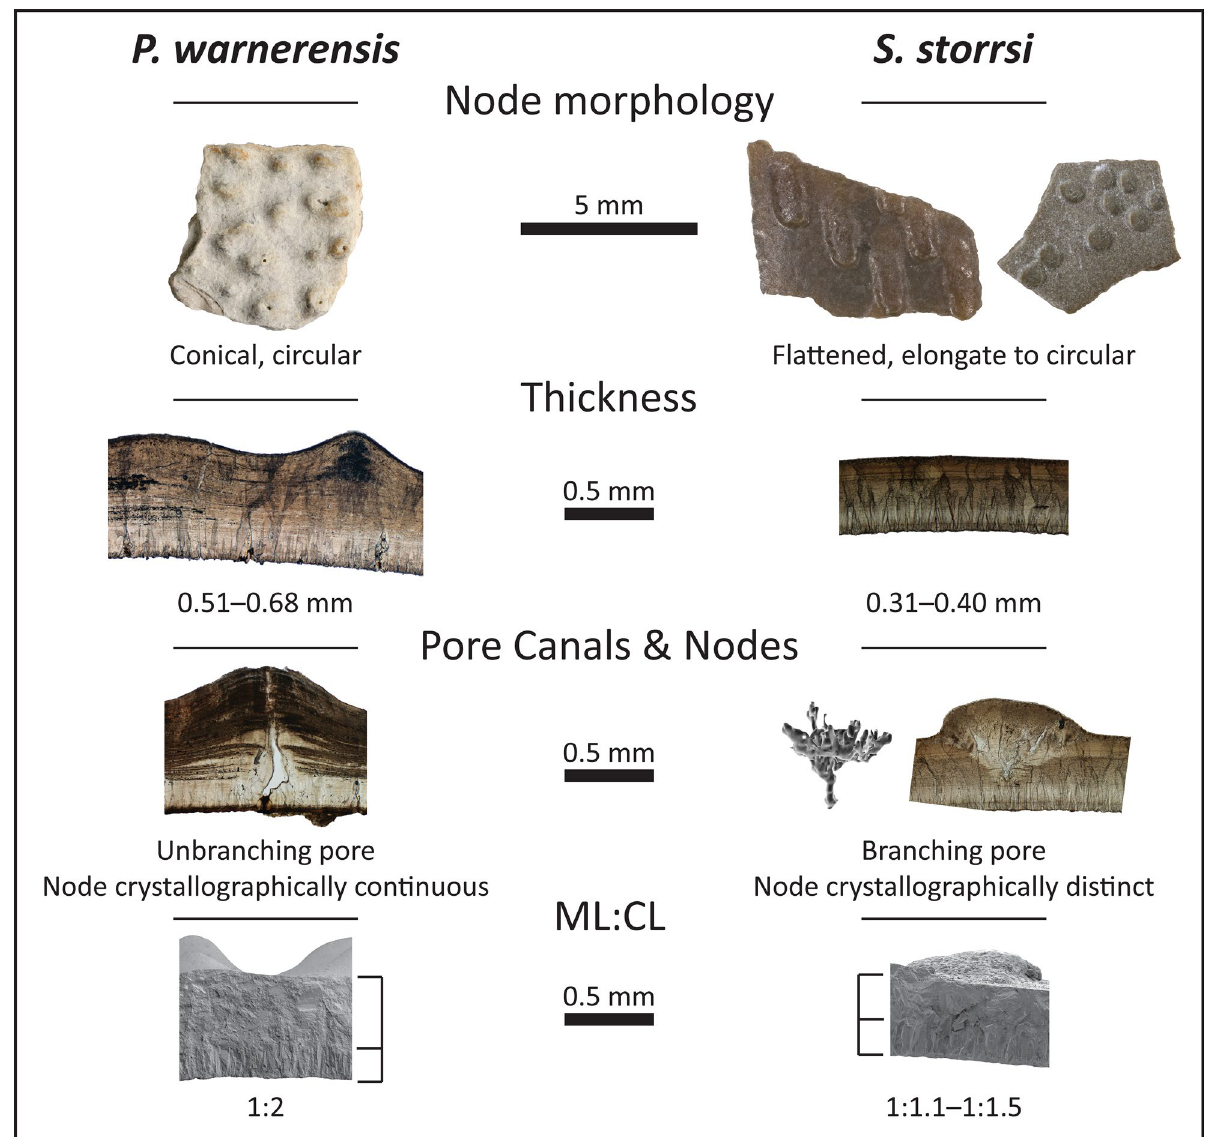
Figure 6. Comparison of Porituberoolithus warnerensis and Stillatuberoolithus storrsi oogen. et oosp. nov. from the Kaiparowits Formation. P. warnerensis specimen numbers from the top-down: DMNH EPV.64663, UCM 1051, DMNH EPV.64663, UCM 1051. S. storrsi specimen numbers cited in previous